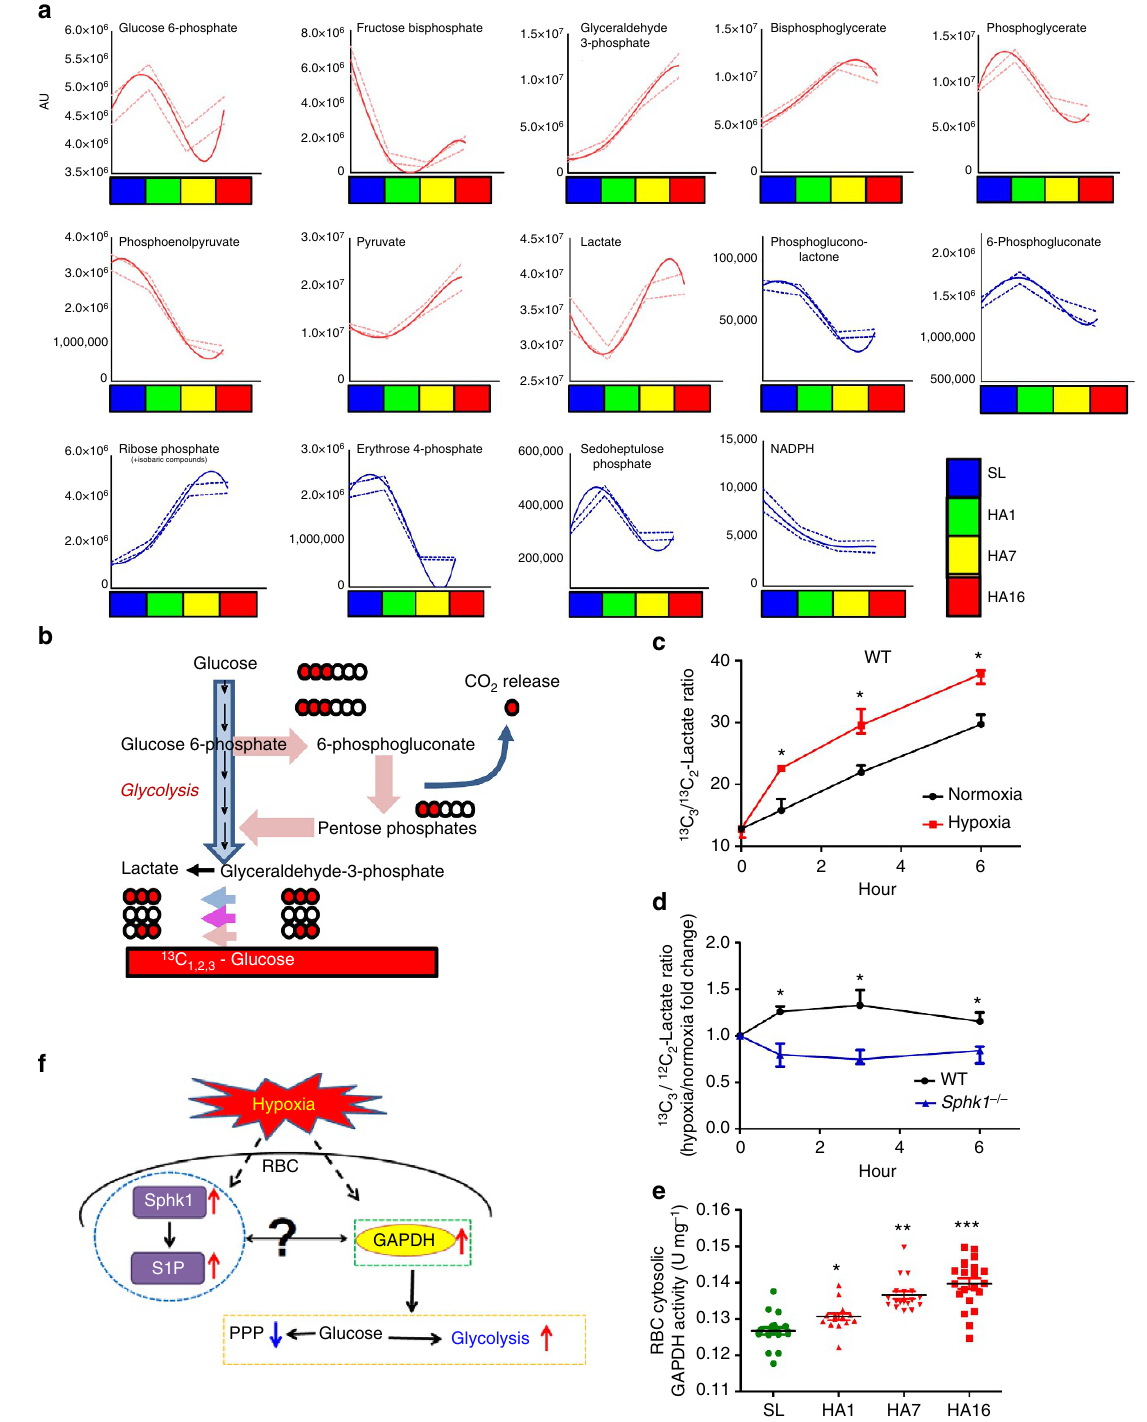
Figure 4 | Alteration of erythrocyte glucose metabolism favouring glycolysis in hypoxia. ( a ) Metabolomic screening revealed time-dependent increase of glycolysis and decrease of PPP in erythrocytes from humans exposed to high-altitude hypoxia. ( b ) Schematic illustration of glucose metabolism flux detection using 13 C 1,2,3 -glucose. ( c ) 13 C 3 / 13 C 2 -lactate ratio determined in WTerythrocytes in normoxia and hypoxia. Fold change of 13 C 3 / 13 C 2 -lactate ratio ( d ) in WT and Sphk1 (cid:2) / (cid:2) erythrocytes in hypoxia to normoxia. ( e ) Erythrocyte cytosolic GAPDH activity in erythrocyte from humans exposed to high-altitude hypoxia. ( f ) Schematic representation showing concurrent change of erythrocyte S1P metabolism with shift of glucose metabolism towards glycolysis in human high-altitude study. Mean ± s.e.m. For human studies, n ¼ 16–21 per group; for mouse studies n ¼ 4 per group; * P o 0.01 versus SL, normoxia or Sphk1 (cid:2) / (cid:2) , ** P o 0.01 versus HA1, *** P o 0.05 versus HA7, Student’s t -test, two-way ANOVA and one-way ANOVA.